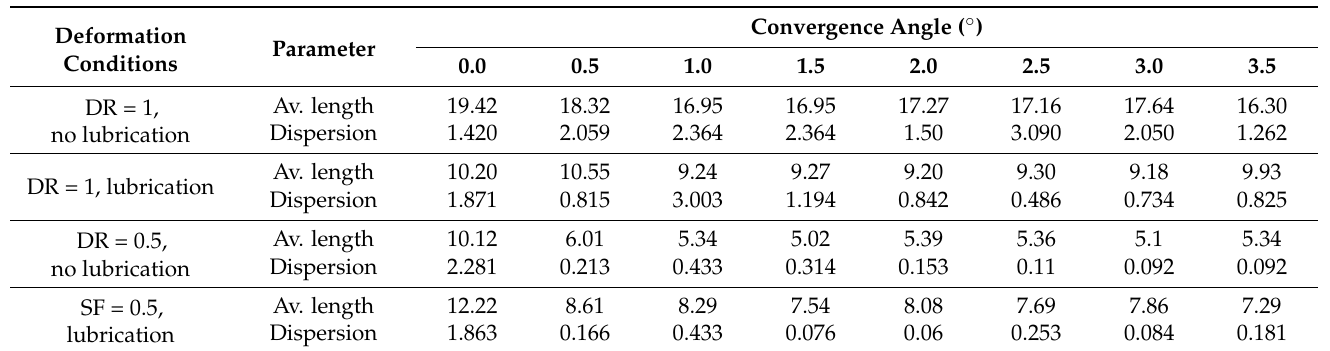
Table 2. Average (Av.) lengths of radial elements of forgings with different dimension ratios (DRs) under different friction conditions (with and without lubrication).